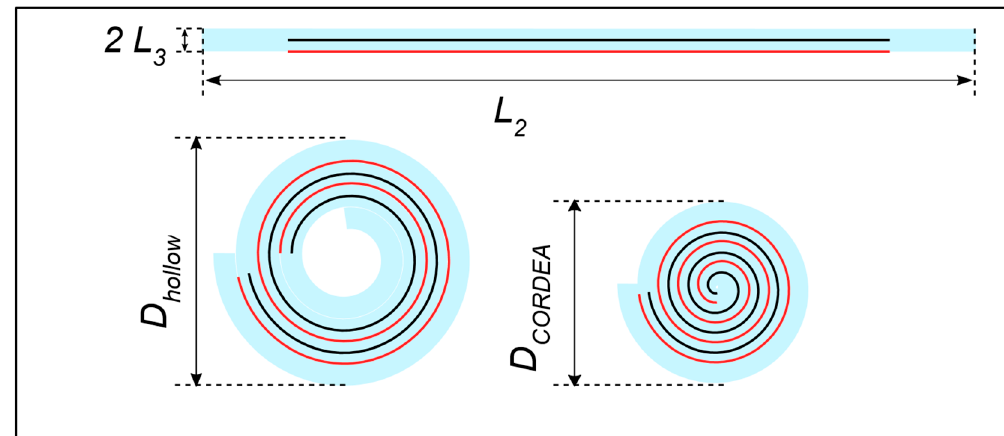
Figure 3. Simplified cross-section of dielectric elastomer (DE) material with electrodes before and after rolling. Flat stacked films (top), hollow RDEA (bottom ‐ left), and coreless rolled dielectric elastomer actuator (CORDEA) (bottom ‐ right) at the bottom.